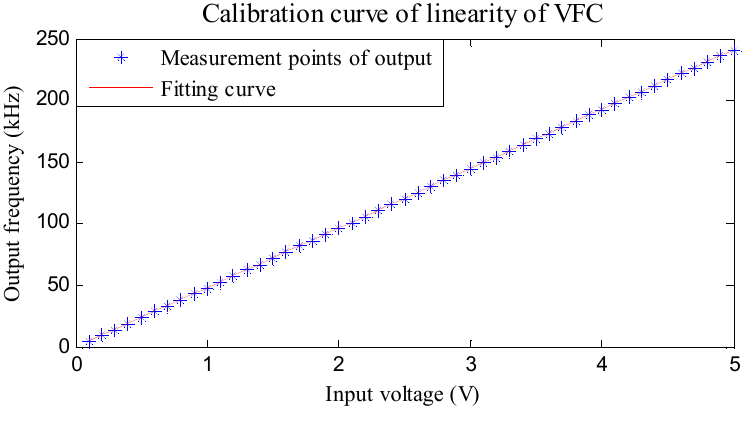
Figure 6. Calibration curve of linearity of VFC.